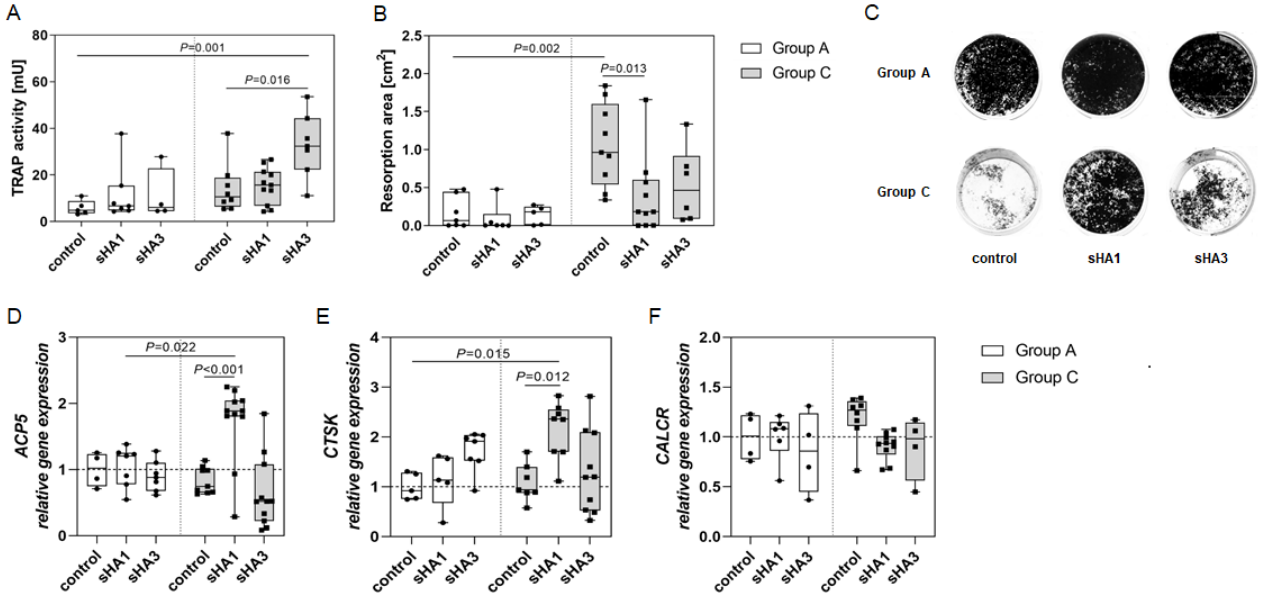
Figure 4. Effect of sHA on TRAP activity, calcium phosphate resorption and gene expression in osteoclasts. PBMC were cultured on a calcium phosphate matrix. ( A – C ) After 14 days of culture with M-CSF/RANKL and sHA (200 µg/mL) TRAP activity ( A ) and resorption activity ( B ) were analyzed. ( C ) Representative images of resorption assays in 24-well plates of M-CSF/RANKL-treated PBMC of an arthritis (upper row) and Charcot patient (lower row) after 14 days of culture. Strong resorption of Charcot patients was diminished after sHA administration. Black: silver-stained calcium phosphate; white: resorbed areas. ( D – F ) After 14 days of culture cells were lysed for RNA isolation followed by reverse transcription and quantitative real-time PCR to evaluate the expression of ACP5 ( D ), CTSK ( E ) and CALCR ( F ). Gene expression was normalized to GAPDH expression and calculated using the CT method. Data are provided as median with interquartile range and min/max values, statistical analyses were performed using ANOVA and Tukey post-hoc test.